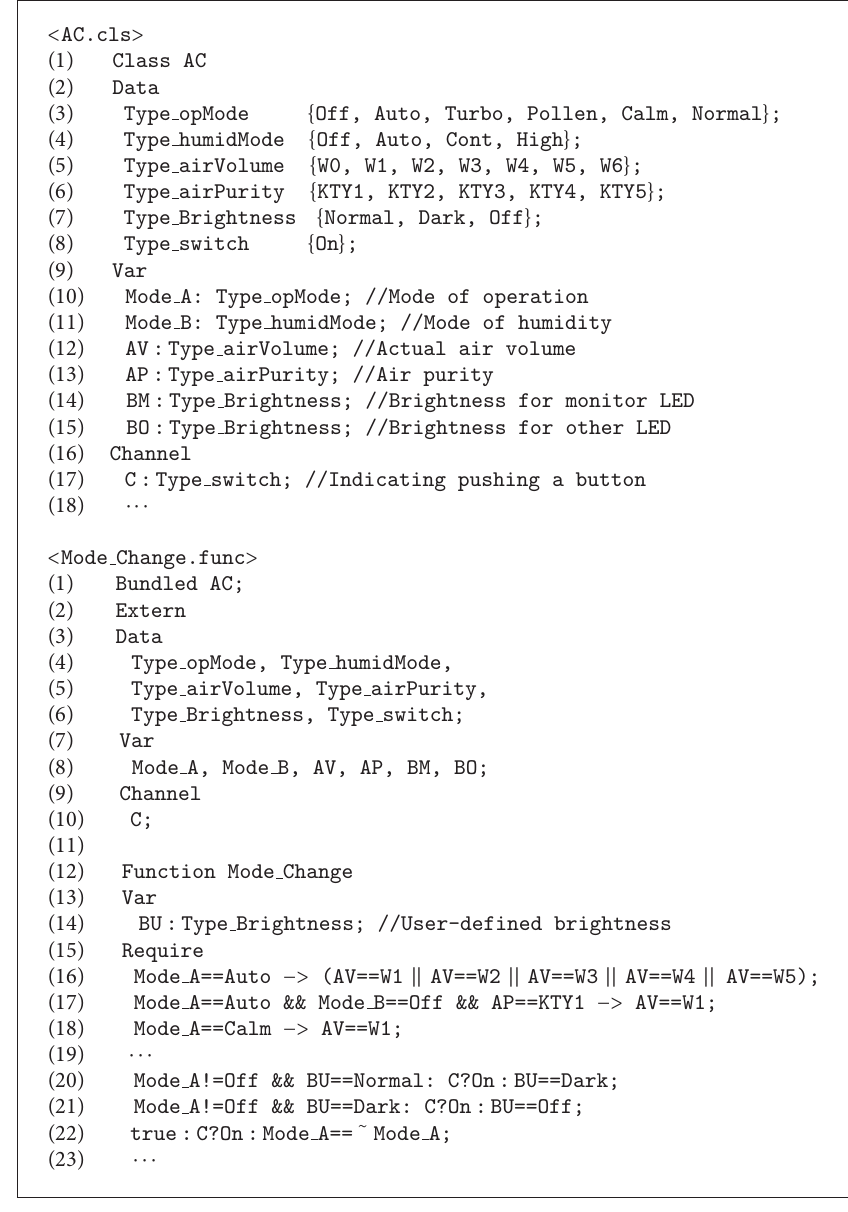
Pseudocode 2: An example SENS specification for an air-cleaning